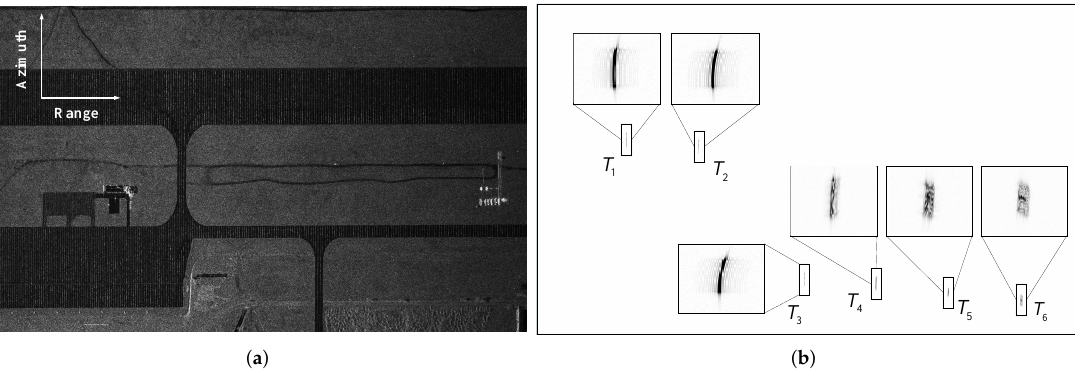
Figure 4. Moving targets detected in the SAR image: ( a ) the zeroth-channel SAR image without clutter suppression; ( b ) the zeroth-channel SAR image after clutter suppression and the detection